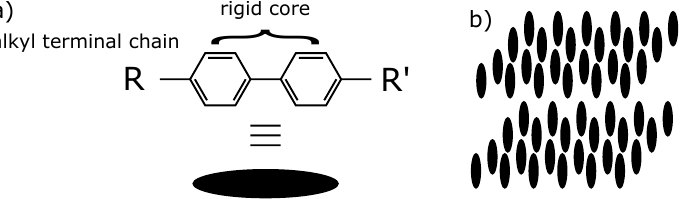
Figure 1. ( a ) Rod shape mesogen calamitic liquid crystal; ( b ) 3D Smectic A